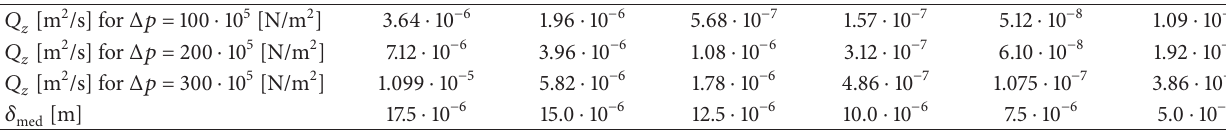
Table 1: Experimental data [3].